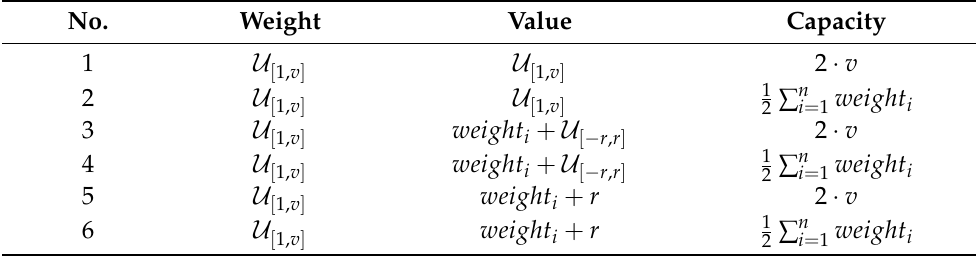
Table 1. Test cases of knapsack